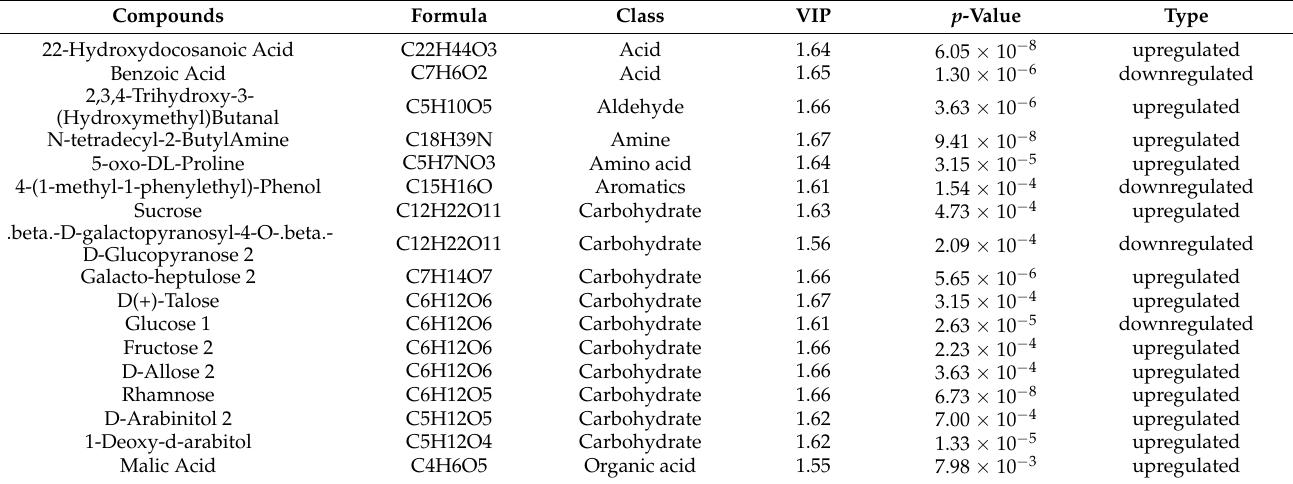
Table 4. Differential metabolites in the FR zone.